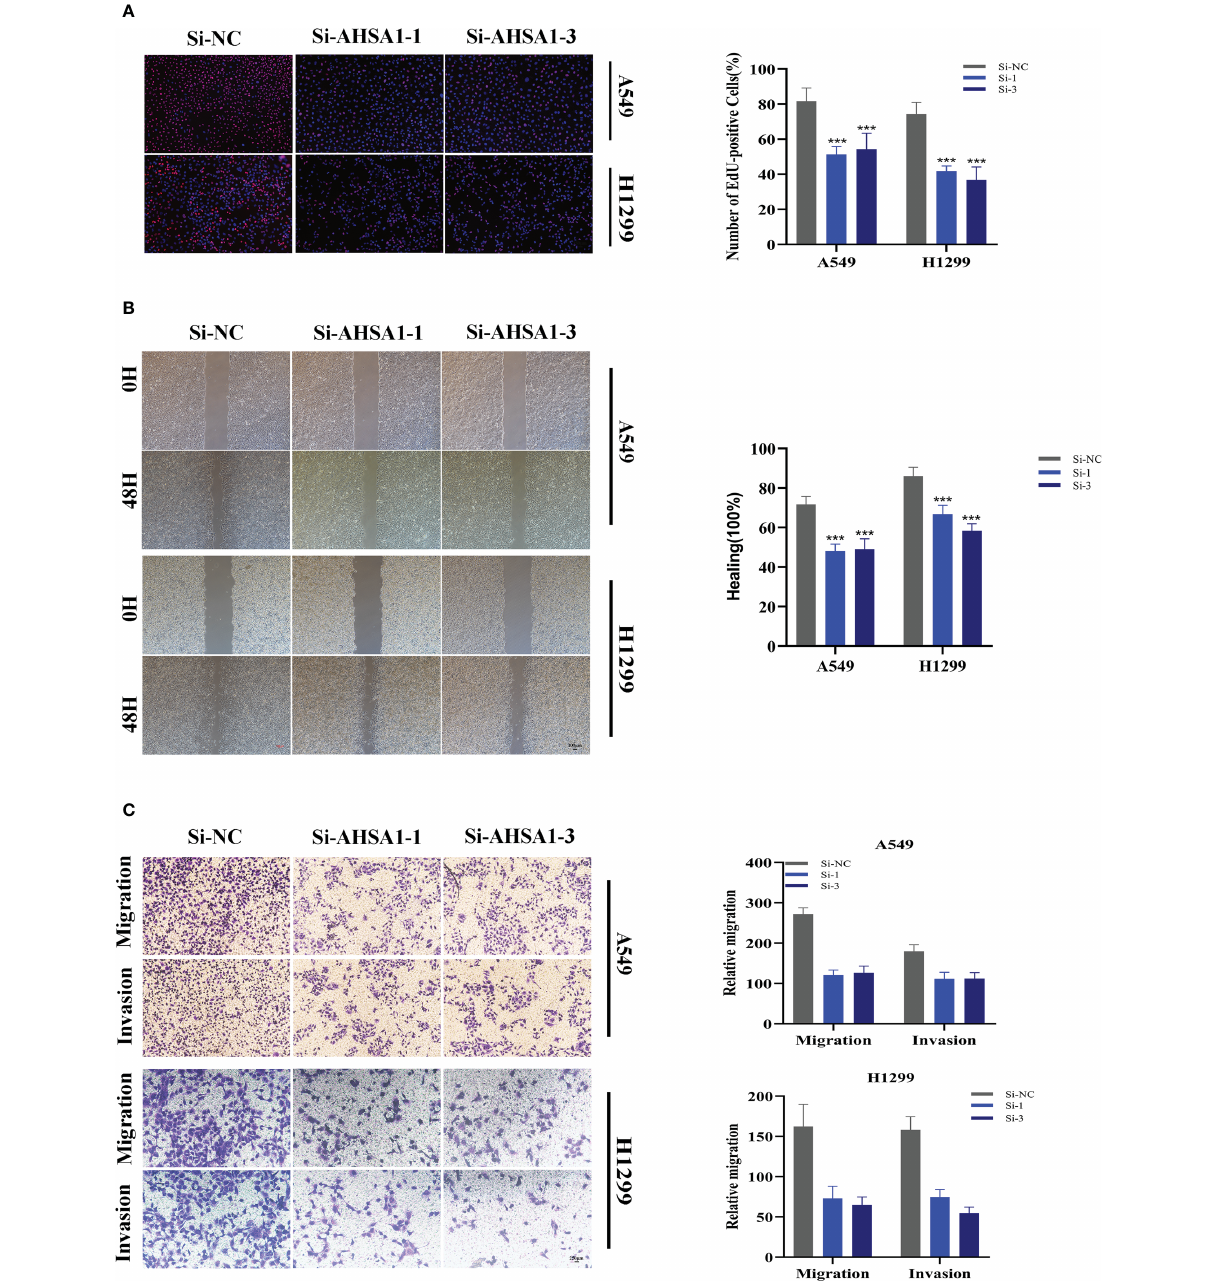
FIGURE 12 Related experiments for AHSA1. (A) EdU staining assay indicated that downregulation of AHSA1 expression repressed cell proliferation in LUAD cell lines. (B) Scratch-wound healing assay depicted that a signi fi cantly slower wound healing rate was observed in cells with a decreased expression of AHSA1. (C) Transwell assay showed that downregulation of AHSA1 expression inhibited the migration and invasion capacity of LUAD cells. To demonstrate the accuracy and reproducibility of the results, all experiments were repeated in two LUAD (A549, H1299) cell lines and all data were presented as the means ± SD of three independent experiments. Note: *** P <